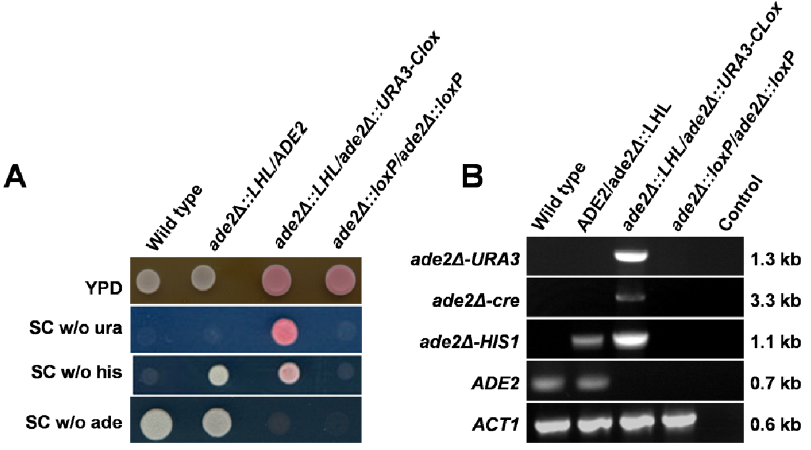
Figure 3. Validation of Clox cassettes for multi-marker gene disruption. The LHL and URA3-Clox cassettes were used to generate a homozygous ade2 D /ade2 D mutation in C. albicans RM1000. (A) Confirmation of the expected auxotrophic requirements for wild type ( ADE2/ADE2 ), heterozygous ( ade2 D ::LHL/ADE2 ), unresolved homozygous ( ade2 D ::LHL/ade2 D ::URA3-Clox ) and resolved homozygous mutants ( ade2 D ::loxP/ ade2 D ::loxP ). Growth media are specified on the right: w/o, without a specific supplement. (B) PCR confirmation of the genotypes for these mutants using primers specific for each allele (specified on the left of each panel). PCR product lengths are given on the right of each panel. ACT1 was used as a positive control, and a no-DNA control was included